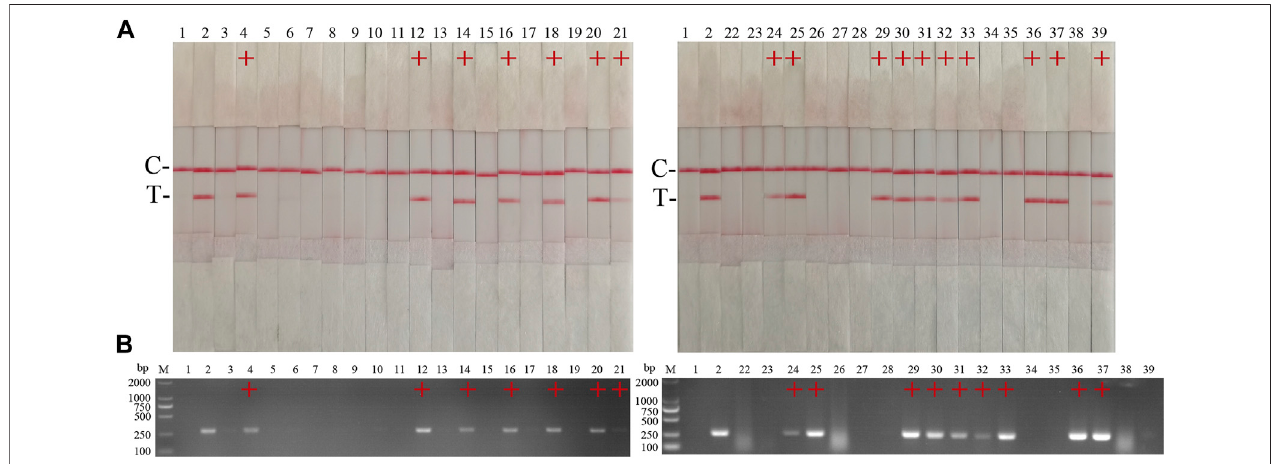
FIGURE 6 | Performance of ASFV RAA-strip on clinical samples. (A) The result of clinical samples detection by ASFV RAA-strip. (B) The result of clinical samples detectionbyASFVconventionalPCR.Cisacontrolline.Tisatestline.Misa2,000 bpDNAmarker,1isanegativecontrol.2ispositivecontrol(3 – 39)aredifferentclinical pig samples reserved in our laboratory, and “ + ” indicates positive detection of ASFV in the samples.